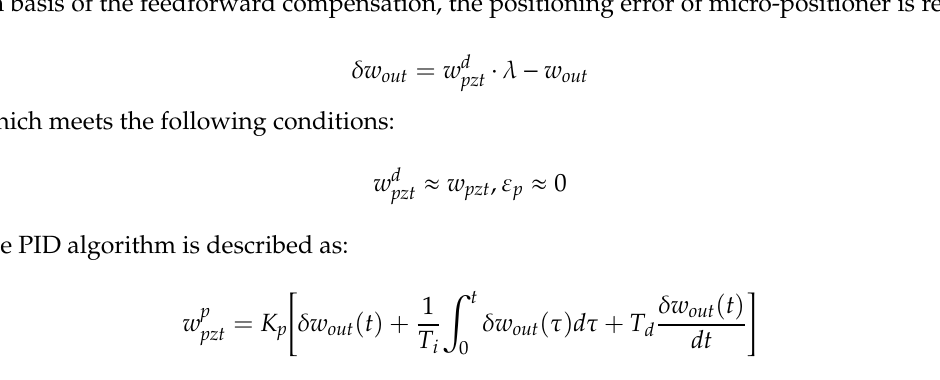
Figure 4. Block diagram of the feedforward plus feedback compensation.